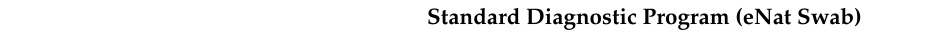
Table 2. Statistical correlation between the standard diagnostic program (eNat swab) and the Testami